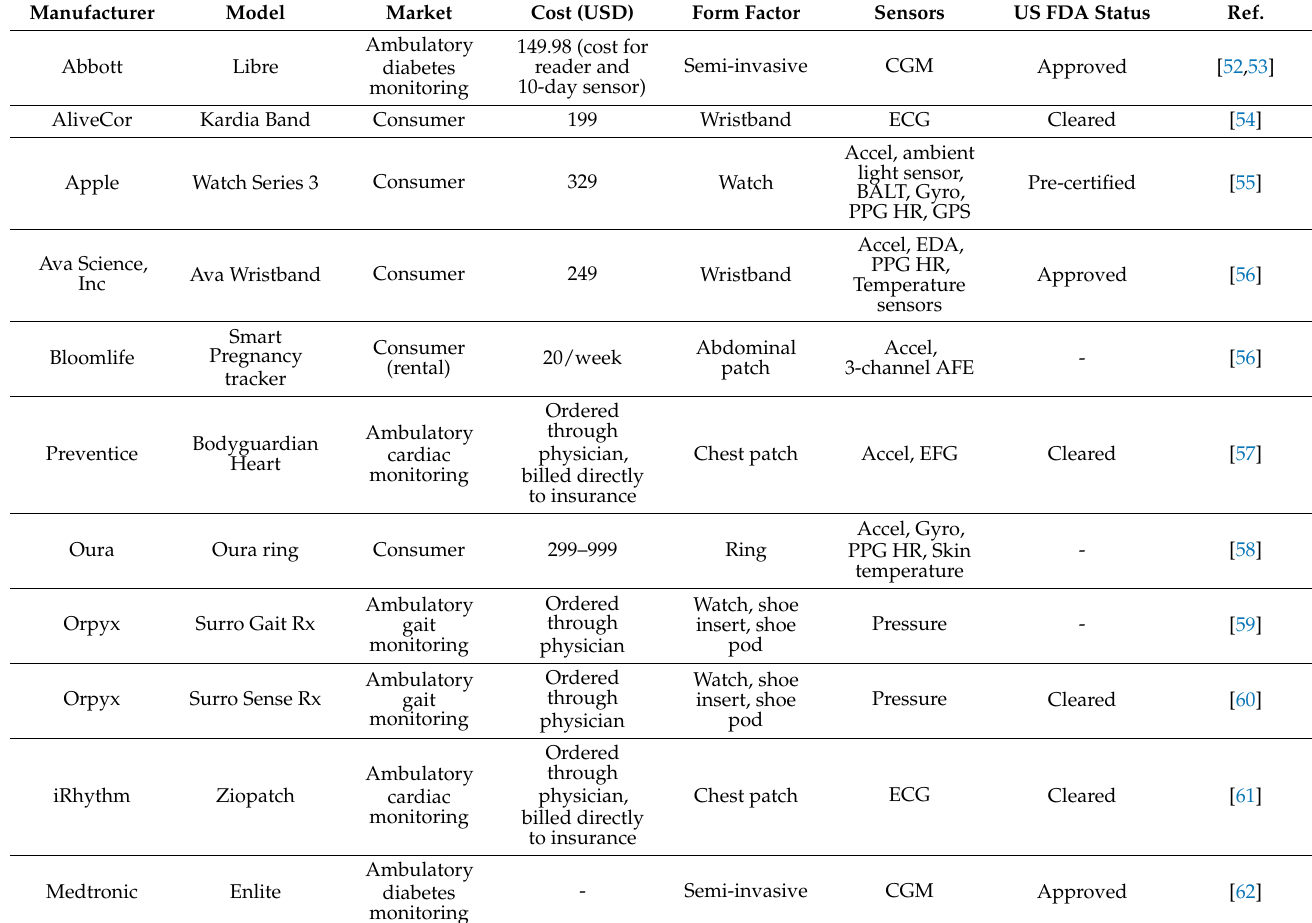
Table 1. Examples of common consumer, clinical, and research-grade wearable sensors